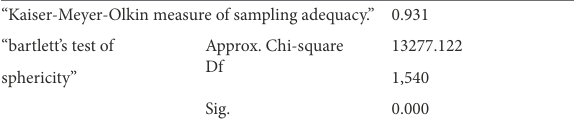
TABLE 3 KMO and Bartlett’s